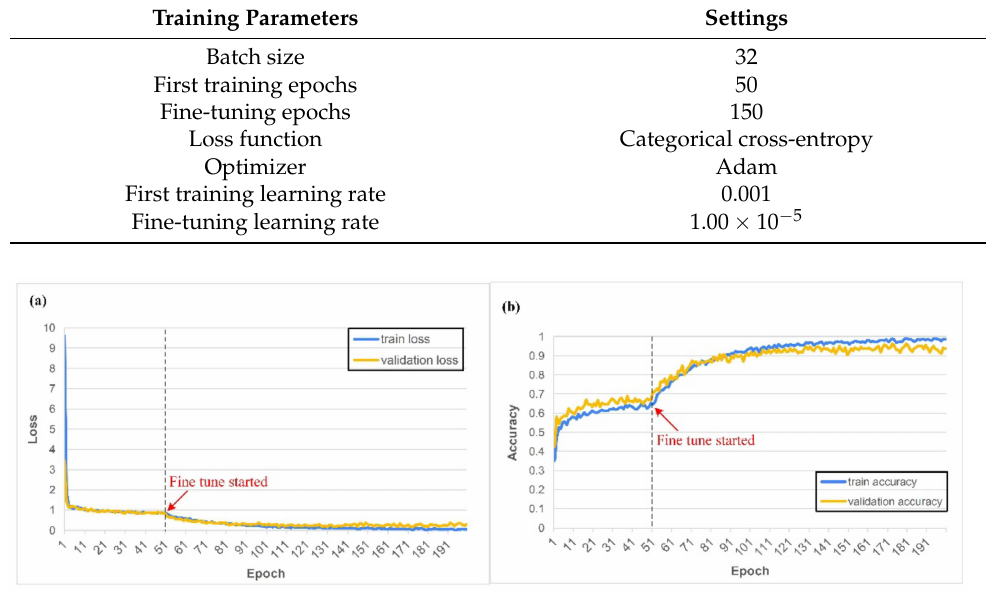
Table 5. The training parameters of the model of the first task: classification of the grit number of the abrasive belt.